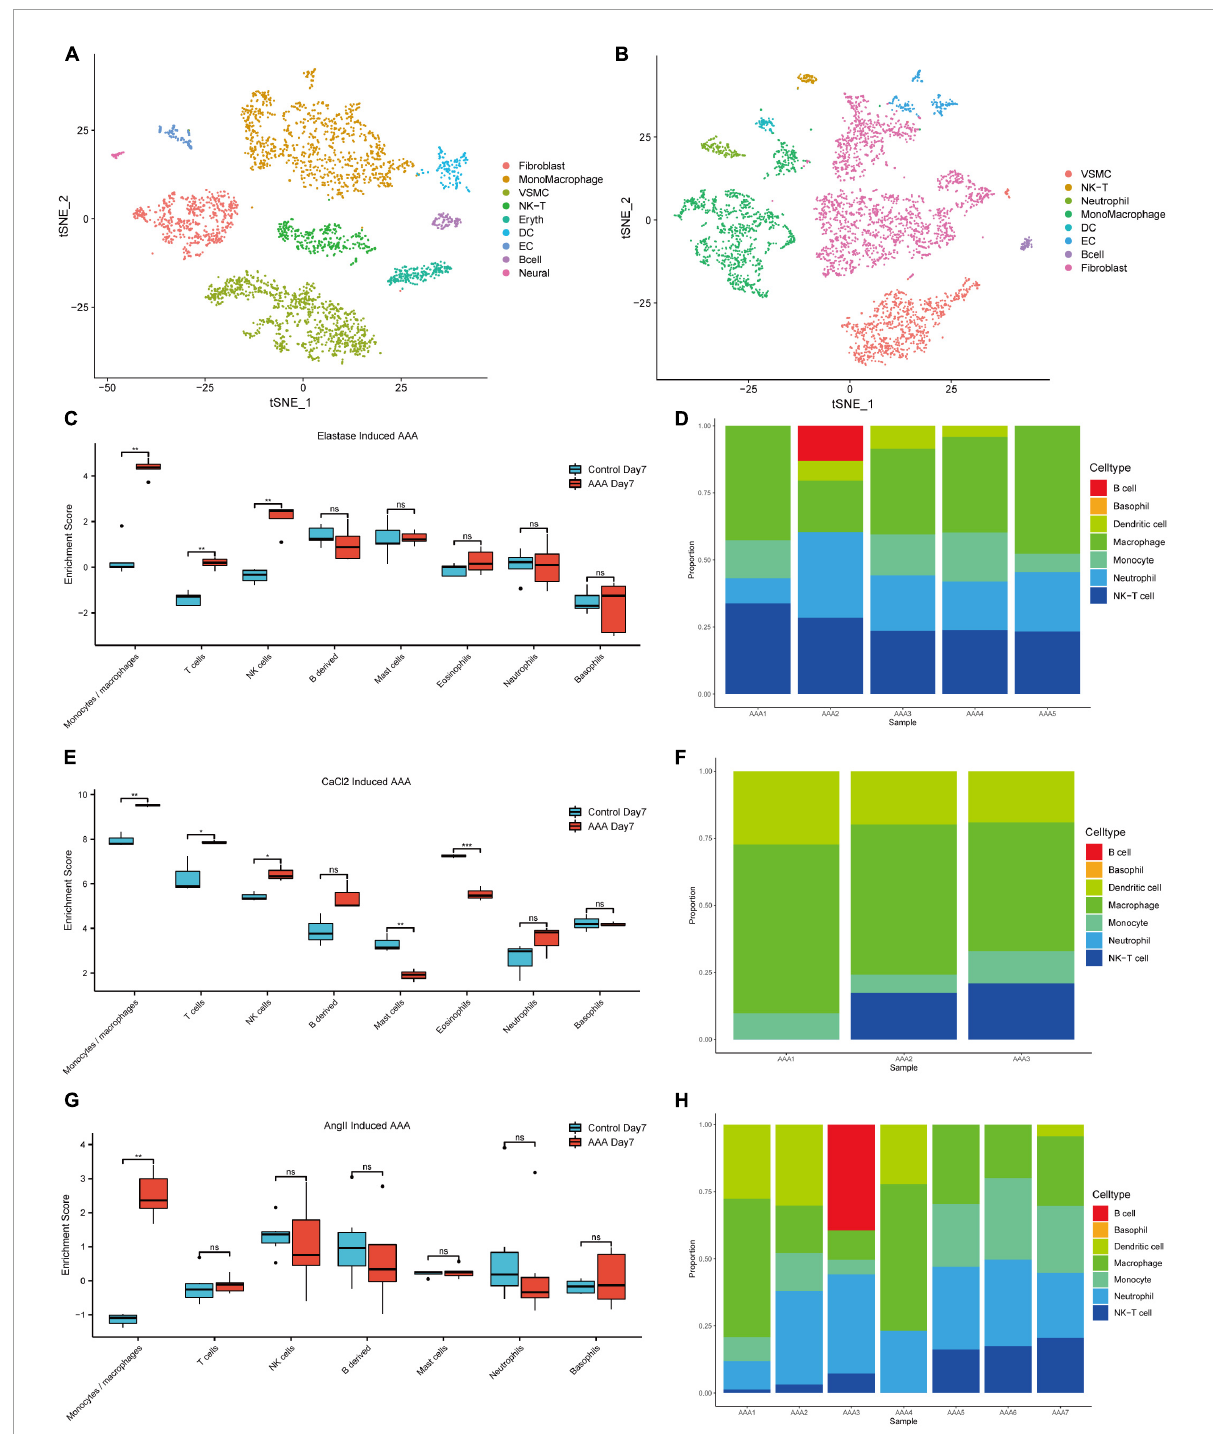
FIGURE1 Immune cell infiltration analysis of the early-stage experimental AAA models. The t-SNE plot for peri-adventitial elastase incubation induced AAA scRNA-seq dataset (GSE152583) which contains elastase-induced AAA samples on day 7 and control aortas (A) . The t-SNE plot for CaCl 2 induced AAA scRNA-seq dataset (GSE164678) which contains CaCl 2 -induced AAA samples on day 4 and control aortas (B) . Boxplot of the mMCP-counter enrichment score of microarray dataset (C) GSE51227 which contains AAA samples induced by intraluminal elastase perfusion on day 7 and control aortas (E) GSE109639 which contains CaCl 2 -induced AAA samples on day 7 and control aortas (G) GSE17901 which contains AAA samples from AngII treated ApoE − / − mice on day 7 and control aortas. Bar graph of the CIBERSORT enrichment ratio of microarray dataset GSE51227 (D) , GSE109639 (F) , GSE17901 (H) (* P < 0.05, ** P < 0.01, *** P < 0.001, ns, not